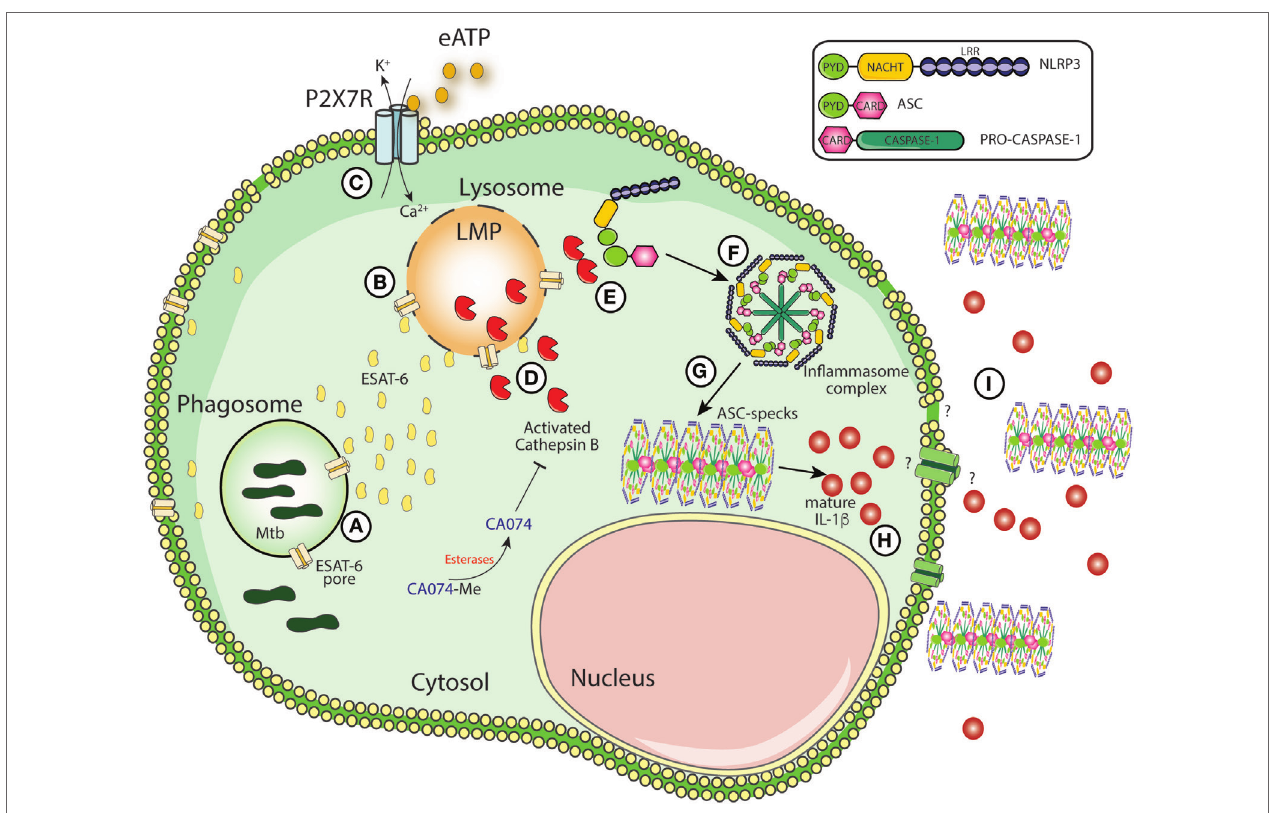
FigUre 5 | Schematic model for mature IL-1 β generation during Mycobacterium tuberculosis (Mtb) infection. The secretion of ESAT-6 in phagosomes by Mtb induces pore formation on phagosomal membranes, facilitating the leakage of ESAT-6 into cytosol and bacterial escape to cytosolic compartment (a) . Once in the cytosol, ESAT-6 may induce pore formation on cellular membranes which could contribute to lysosomal perturbation (LMP) (B) . Simultaneously, extracellular ATP is recognized by P2X7 receptor and amplify LMP-induced by Mtb or vice versa (c) . LMP releases lysosomal enzymes, such as cathepsin B (CTSB) (D) . Once in the cytosol, activated CTSB supports the interaction between NLRP3 and ASC (e) facilitating the NLRP3-inflammasome assembly following caspase-1 recruitment (F) . Several molecules of ASC and caspase-1 will be recruited to NLRP3-complex leading the formation of the ASC speck core (g) , which amplifies IL-1 β production (h) . The secretion of ASC specks and IL-1 β to extracellular milieu may exacerbate inflammation (i)